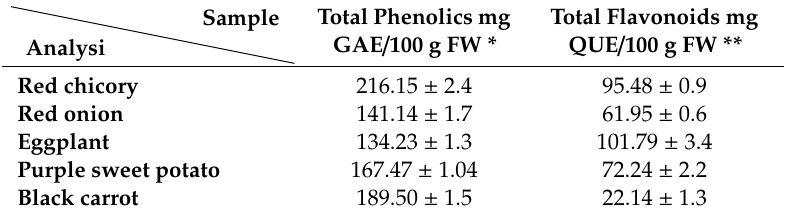
Table 1. Total Phenolics and Flavonoids content of the selected